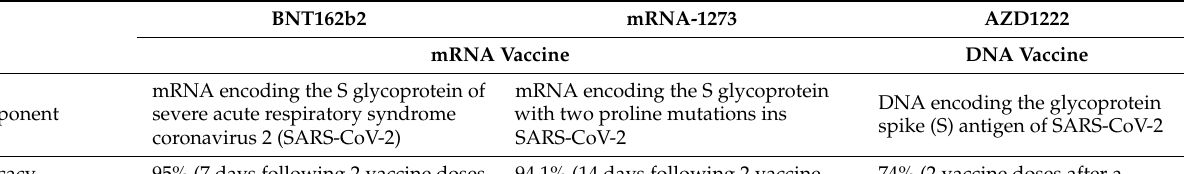
Table 2. Brief Summary of BNT162b2, mRNA-1273, and AZD1222, as well as the associated allergy tests. BNT162b2 mRNA-1273 AZD1222 mRNA Vaccine DNA